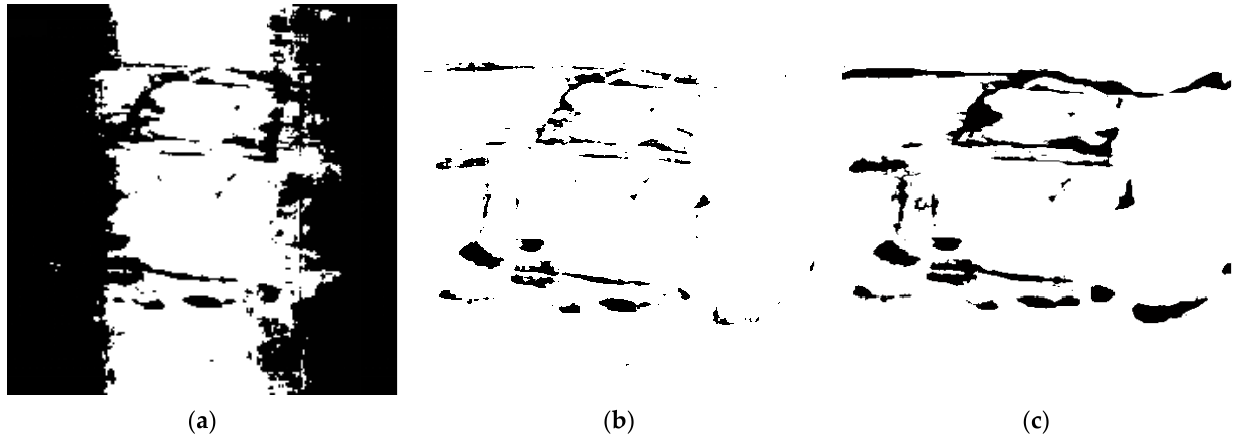
Figure 6. Comparison between the pore identification results of various methods: ( a ) eccentricity recognition, ( b ) traditional threshold segmentation recognition, and ( c ) the present identification method.